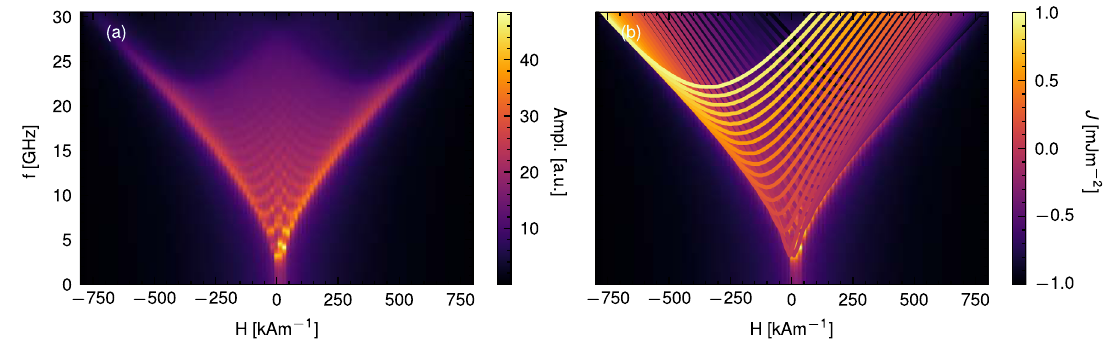
Fig. 5 PIMM scans of the CoFe(2.1 nm)/Cu(1.9 – 2.37 nm)/CoFe(1 nm)/NiFe(5 nm) system in the function of IEC constant J linear . a spectrum of multiple IEC values in ( − 1,1 mJ m − 2 ) was combined into a single map. The colour indicates the total frequency amplitude summed over all PIMM simulations. b Illustrates the same PIMM, but with a marked maximum amplitude resonance line for each J linear value mapped accordingly to the colour scale. The colour scale attached represents different IEC values, from − 1 to 1 mJ m − 2 . We observe the shift of the resonance curve towards the centre for smaller absolute IEC values. Note that at H = 0 the system still exhibits non-zero oscillation. Parameters used for simulation can be found in Supplementary Table 2. Field applied along at 45° angle between x and y axes. based on the Smit – Beljers model 37 (dashed ivory line), which yields more precise results for a multilayer case. The key effect modelled in Fig. 4a – c is the increase of the zero- fi eld oscillation frequency when the IEC increases with absolute value. In Fig. 4d the simulation captures the shift of the resistance loop at ϕ = 90° and the widening of the resistance curve peak at H ϕ